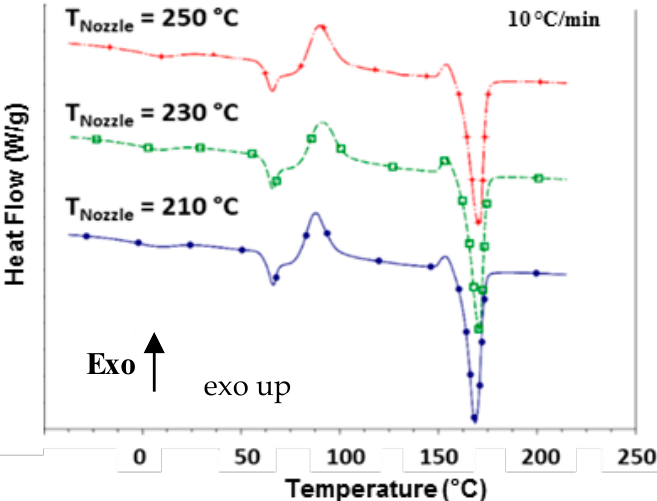
Figure 13. DSC curves of PLA/Hytrel-20% at different nozzle temperatures.